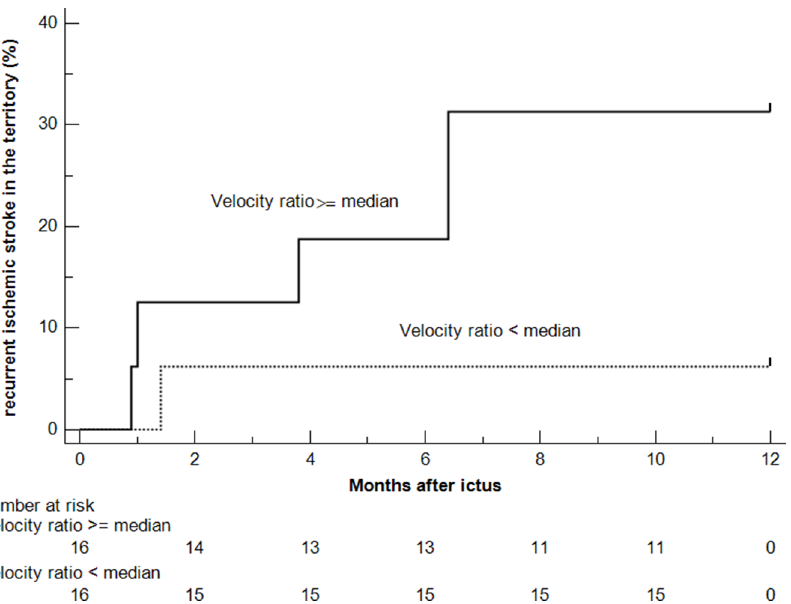
Figure 3. Kaplan-Meier curves for the cumulative probabilities of recurrent ischemic stroke in the territory (SIT) of the stenotic artery within 1 year after ictus, according to the velocity ratio ( $ or , median) as evaluated on the computational fluid dynamics models. Intracranial atherosclerotic lesions with a velocity ratio of $ median may relate to a higher risk of SIT, compared with lesions with a velocity ratio of , median (HR 5.483; 95% CI, 1.105–27.211; log-rank P=0.079).